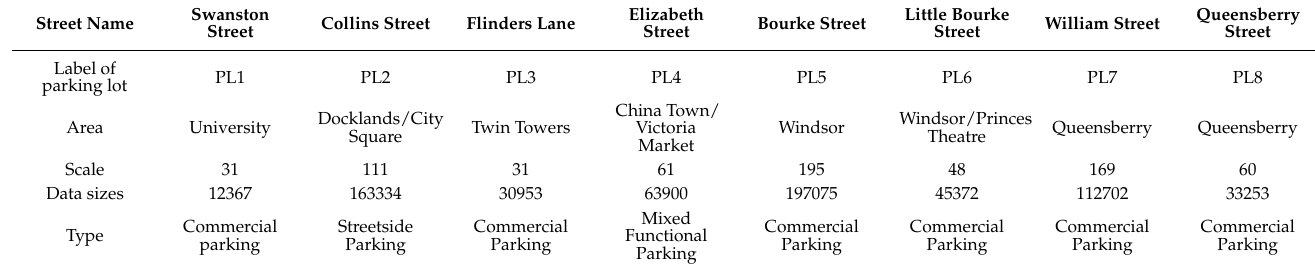
Table 1. The basic information of the eight parking lots.